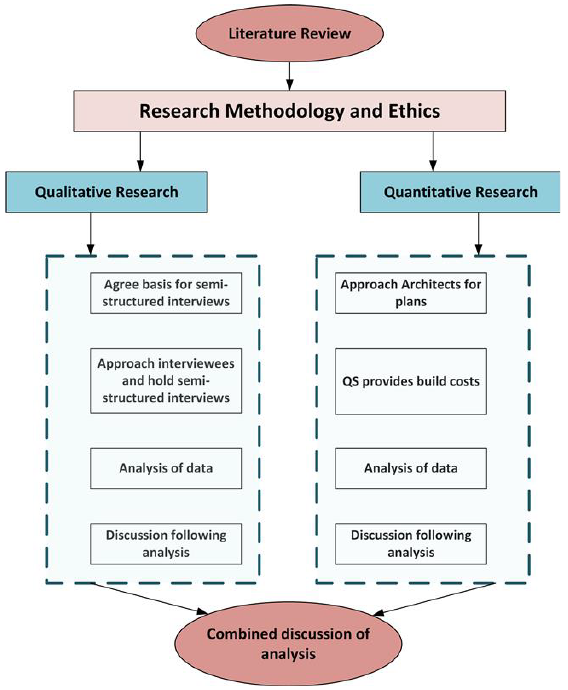
Figure 1. Research Design